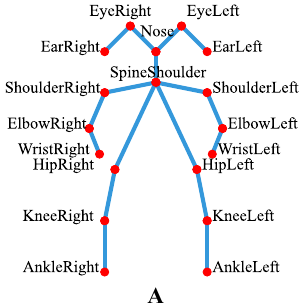
Figure 2. ( A ) 18-joint skeleton of RealSenseD435. ( B ) The 3D coordinates of the wrist joint in the Shoulder/Elbow part motions. Left: The curves of raw RealSense (RS) data, data processed by two denoising methods, and Vicon data of motion I. Right: The SSA-filtered RS data and the Vicon data of four motions, and the red dots mark the motion start and end